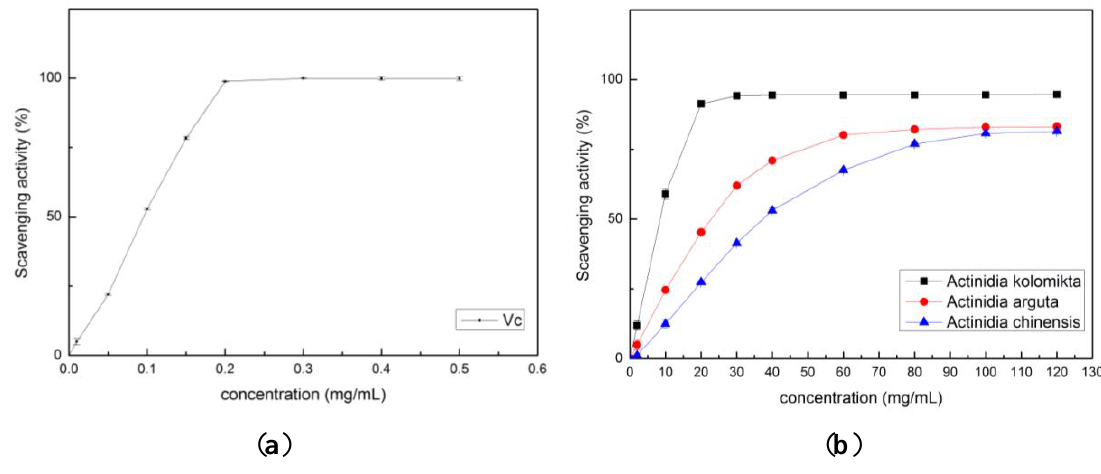
Figure 2. ( a ) Hydroxyl radical scavenging activity of vitamin C; ( b ) Hydroxyl radical scavenging activity of three Actinidia ethanol extracts.